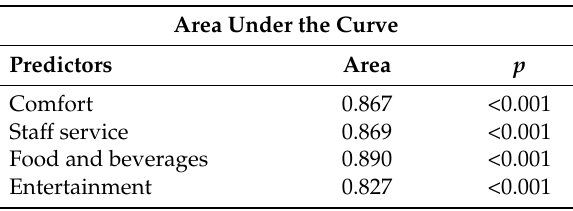
Table 5. Correct rate of